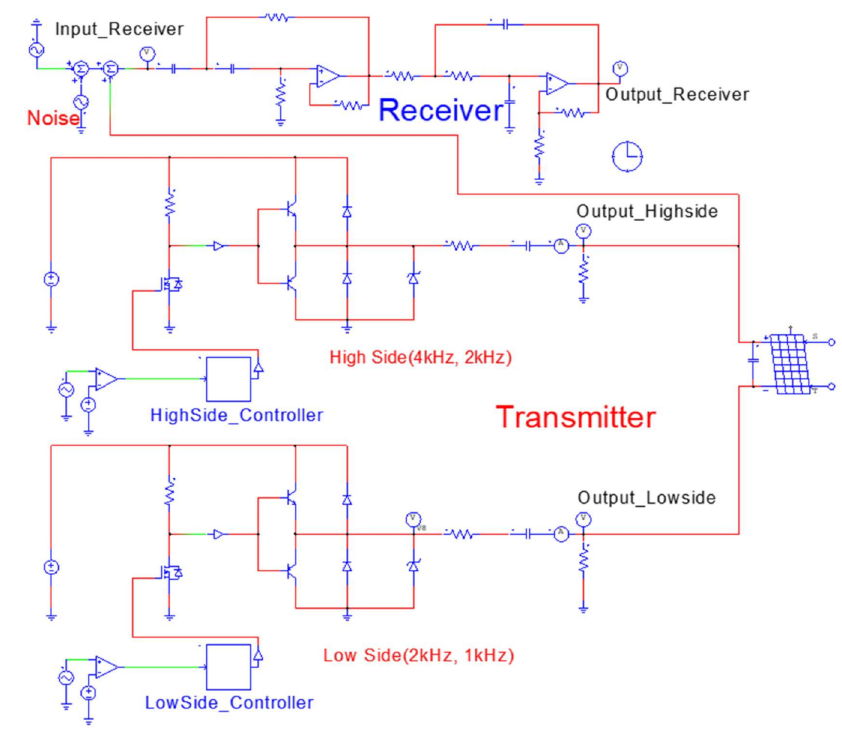
Figure 16. Transmitter and receiver circuit for disconnection failure detection.